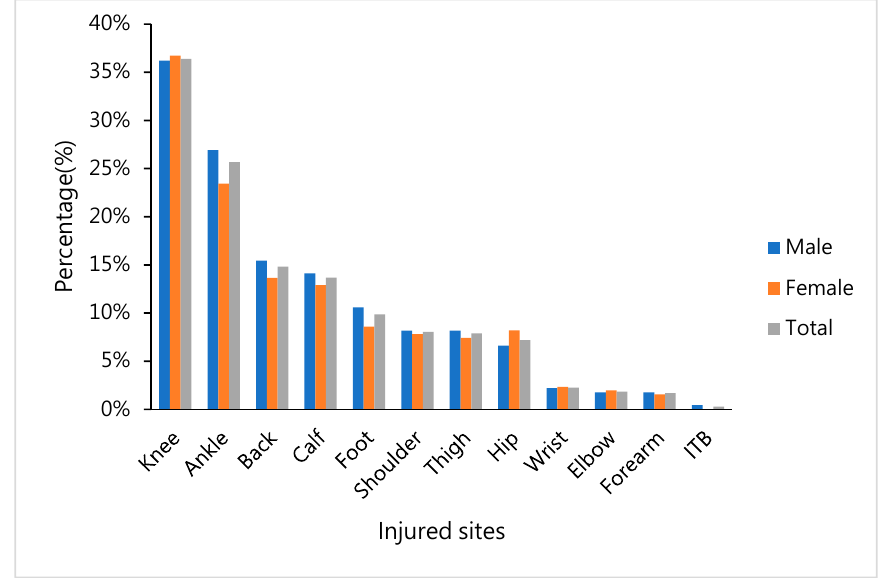
Figure 1. Percentage of self-reported previously injured sites in the body before the gorge marathon, shown for men, women, and total percentage.